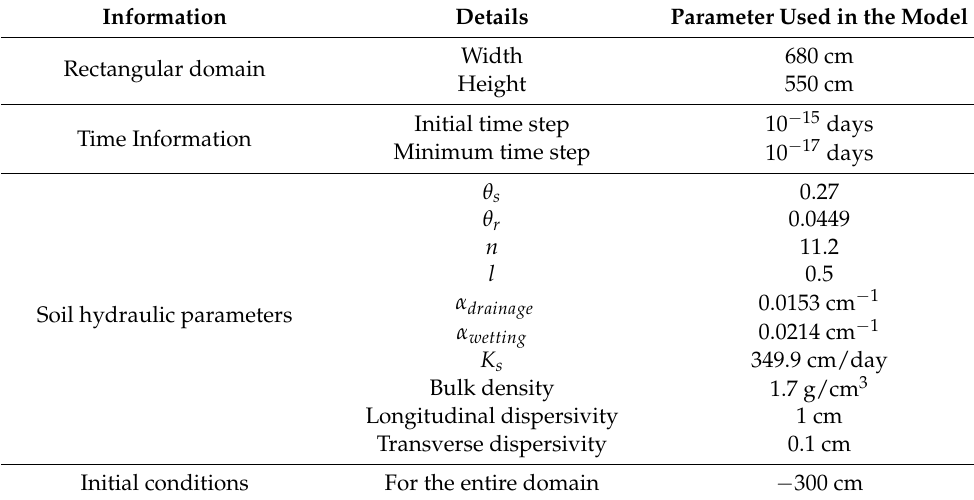
Table 1. Summary of the selected parameters for the numerical